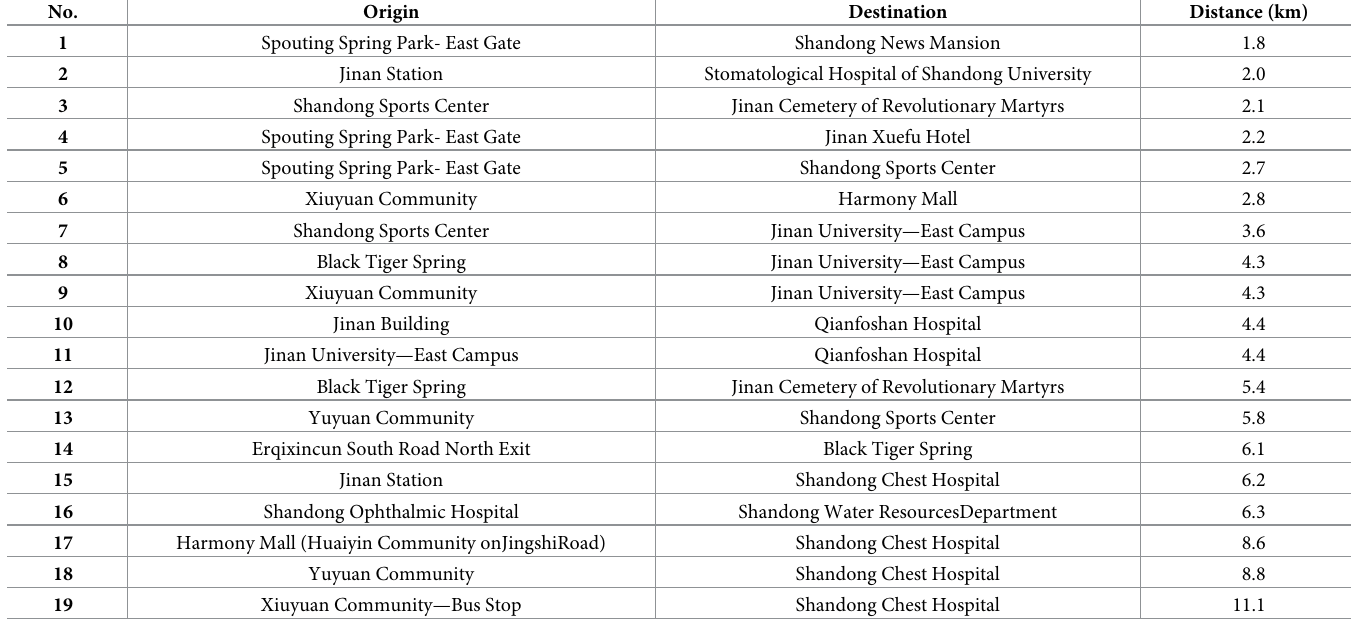
Table 2. Origins, destinations, and length of stretches of the 19